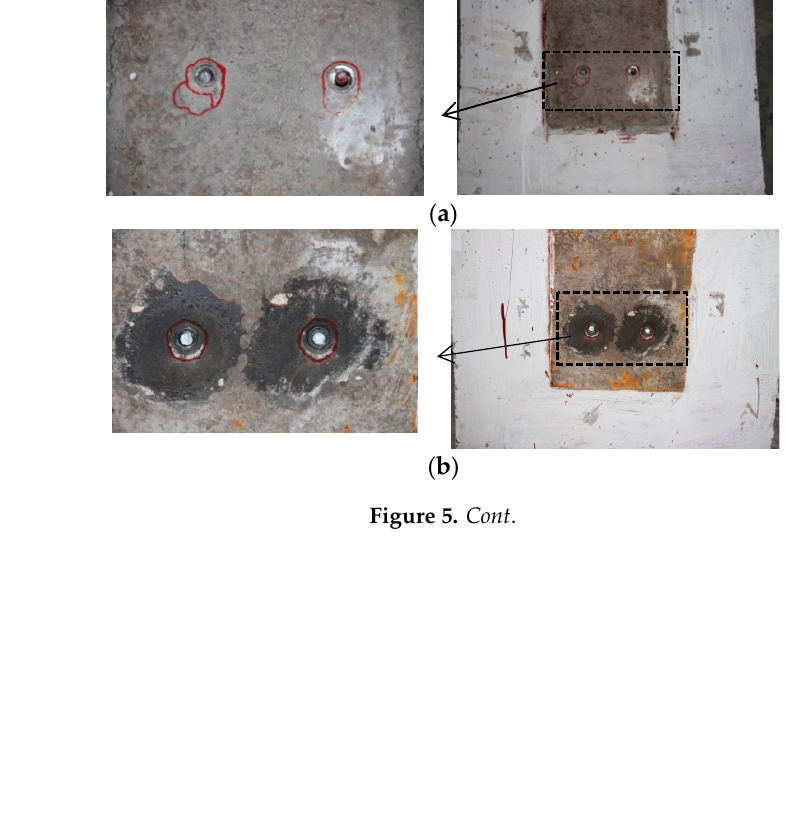
Figure 4. Load-displacement curves for push-off tests: ( a ) specimens of 10 mm; ( b ) specimens of 12 mm; ( c ) specimens of 16 mm.